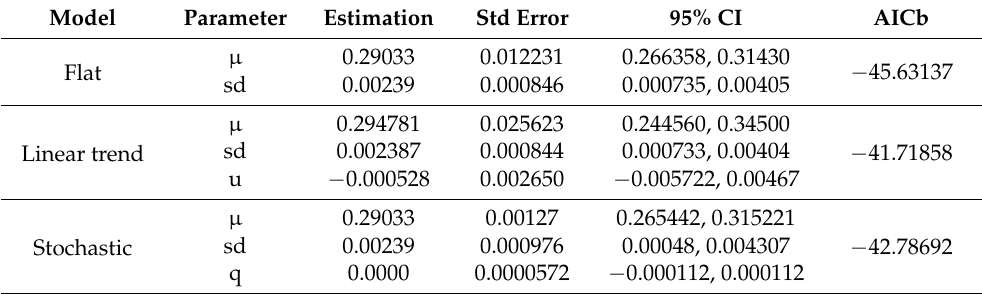
Table 2. Comparison of the three models for the hunting harvest variable.